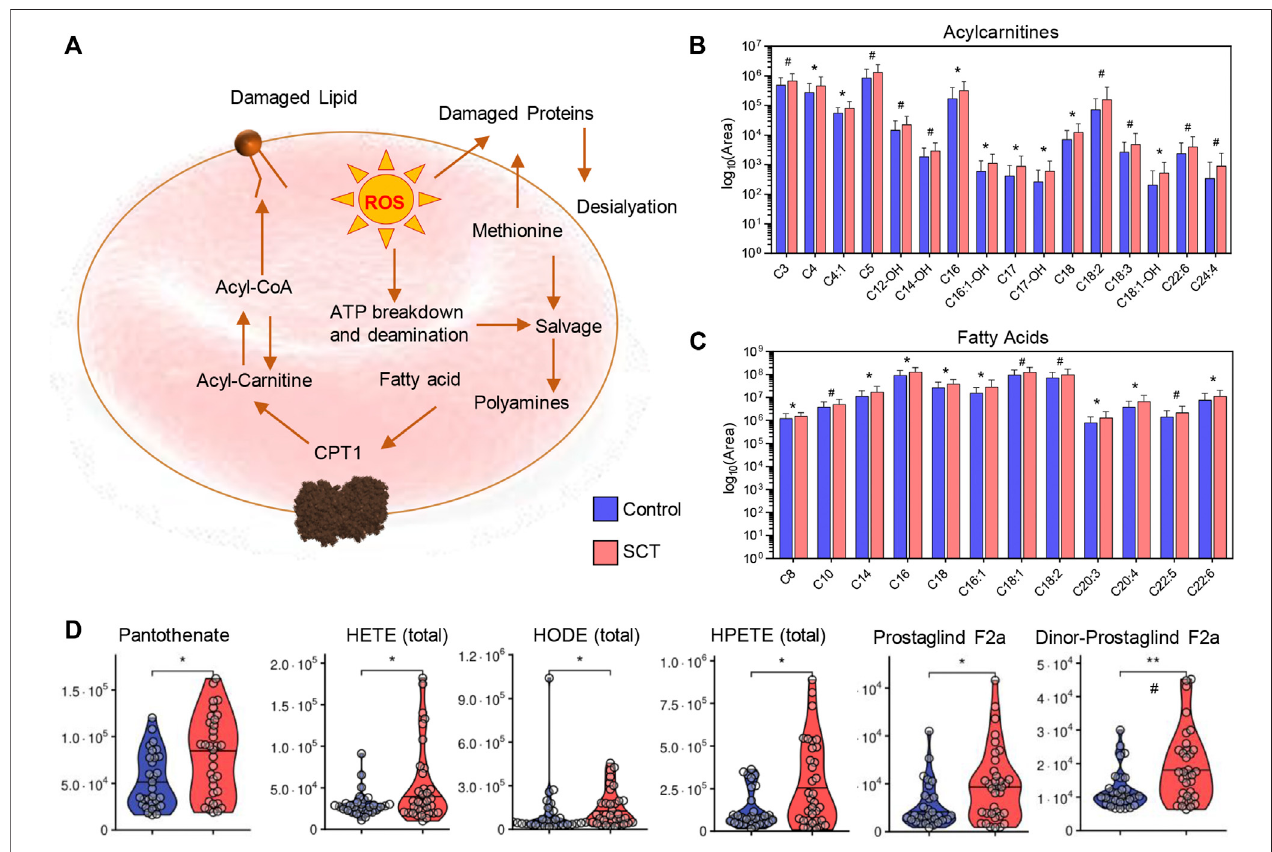
FIGURE8 | Overview of the Lands cycle (A) with a focuson acylcarnitines — (B) and free fatty acids — (C) ,CoA and oxylipin metabolism (D) in plasma from control (blue)andsicklecelltrait(red)subjects.Asterisksindicatesigni fi cance(* p < 0.05;** p < 0.01;*** p < 0.001Wilcoxon/Mann-Whitney U -test).FDR-corrected p -valuesare provided for all analytes in Supplementary Table S1 and indicated with # using the same signi fi cance ranges as per the asterisks in p -values above.